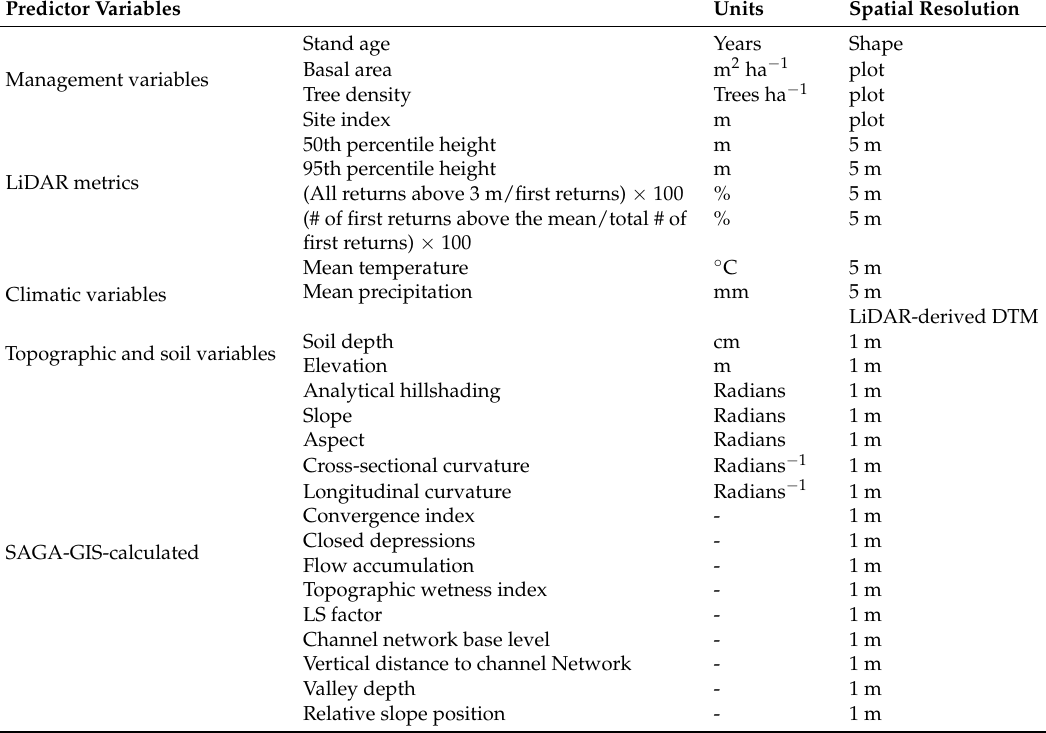
Table 2. Description of prediction variables, units, and spatial